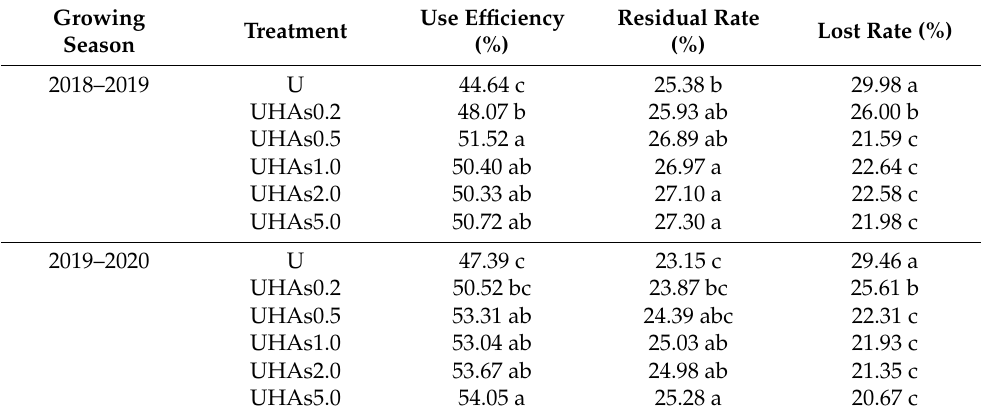
Table 5. Fate of fertilizer-N under different proportions of HAs in urea fertilizer formulations.